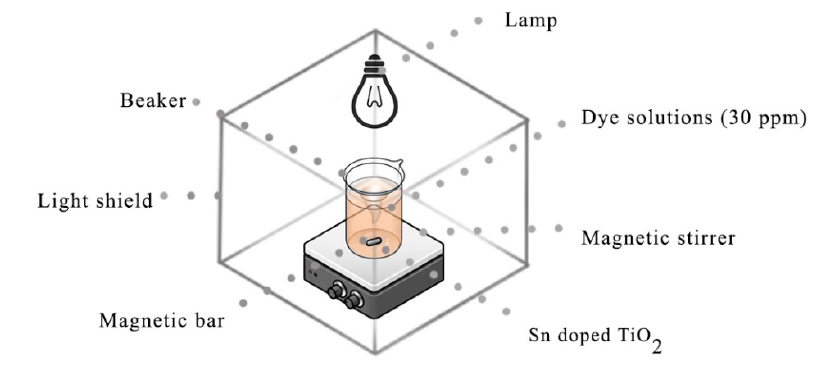
Fig. 1. Schematic diagram of photoreactor